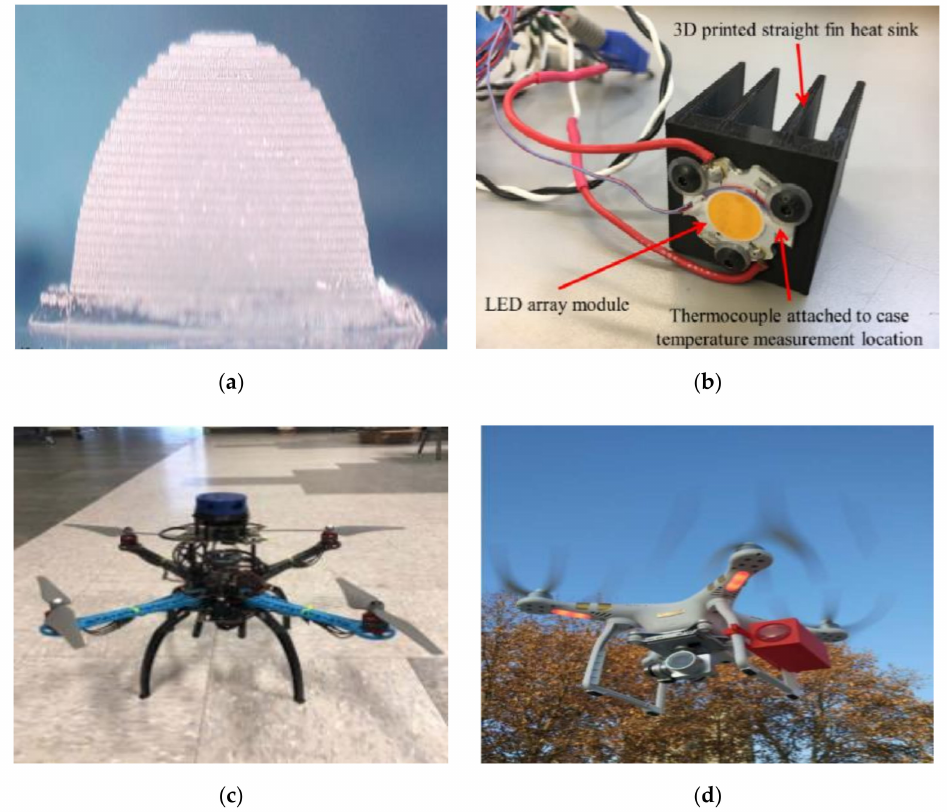
Figure 8. Application of 3D technology: ( a ) 5 mm diameter dome with 2.5 mm dome height on cylinder base of 1.5 mm height [81]; ( b ) 3D printed straight fin heat sink with LED array module mounted [82]; ( c ) UAVs equipped with lidar and 3D printed spiral wings [83]; and ( d ) the pod is tested in the open air